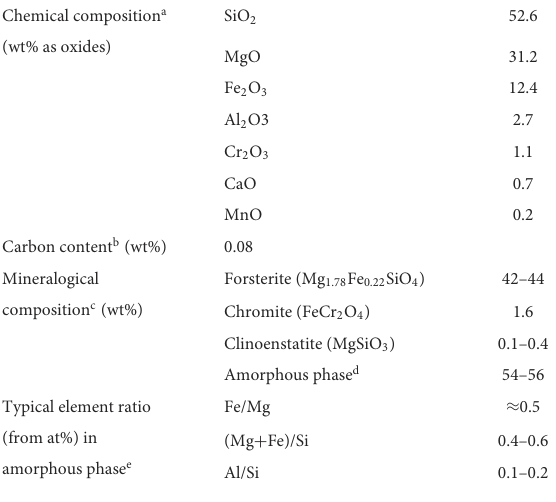
TABLE 1 Measured chemical and mineralogical composition of SLN ferronickel slags. Chemical composition